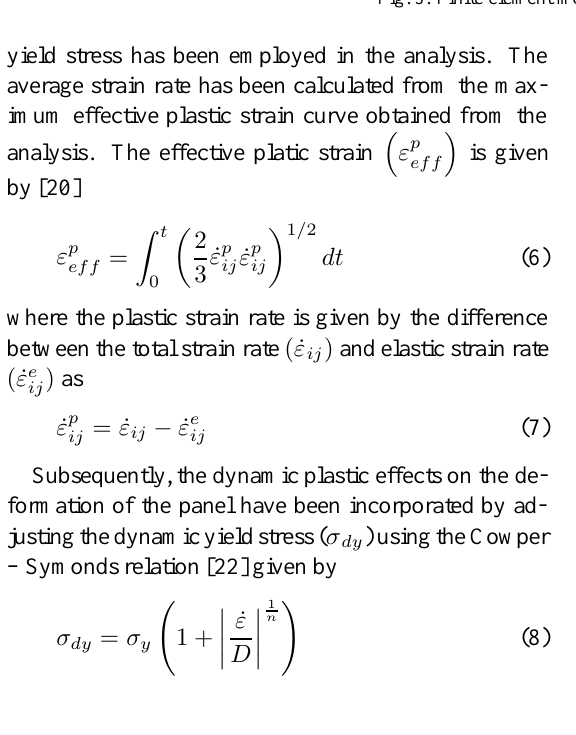
Fig. 3. Finite element modelling of the shell